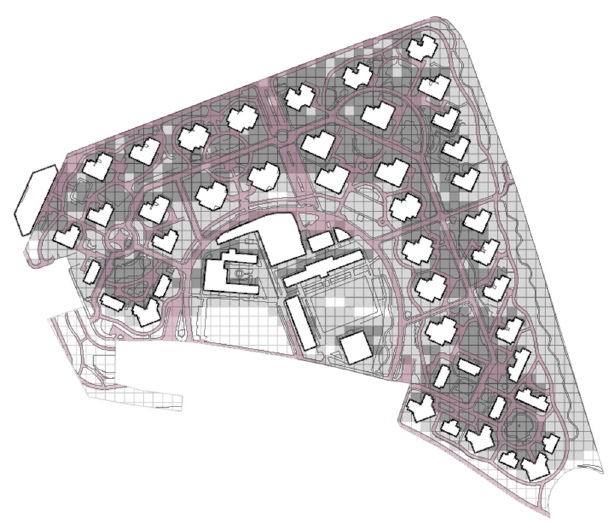
Figure 4. Model overlay of site E showing actual roads and parking areas.